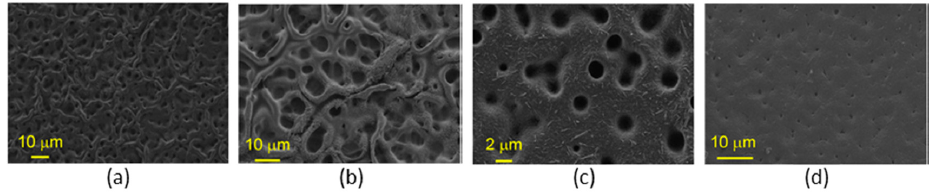
Figure 32. SEM images from [PAH/PAA] nanostructures that have been embedded with